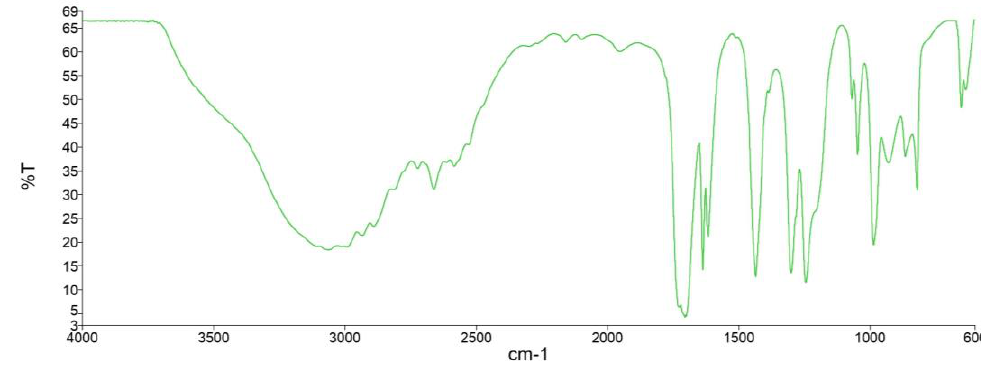
Polymers 2023 , 15 , x FOR PEER REVIEW